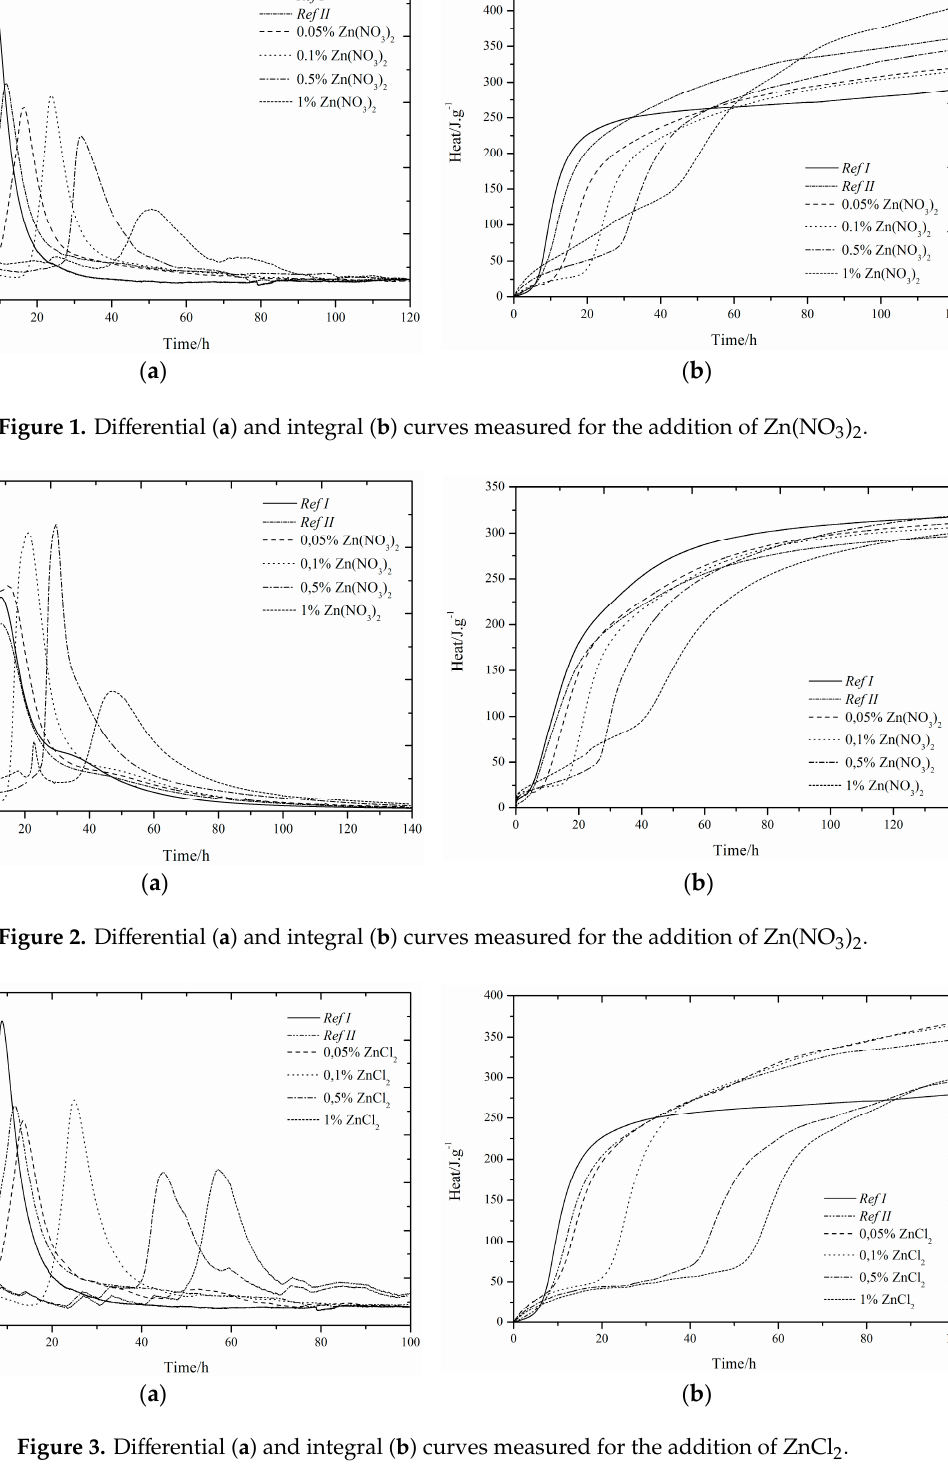
Figure 3. Differential ( a ) and integral ( b ) curves measured for the addition of ZnCl 2